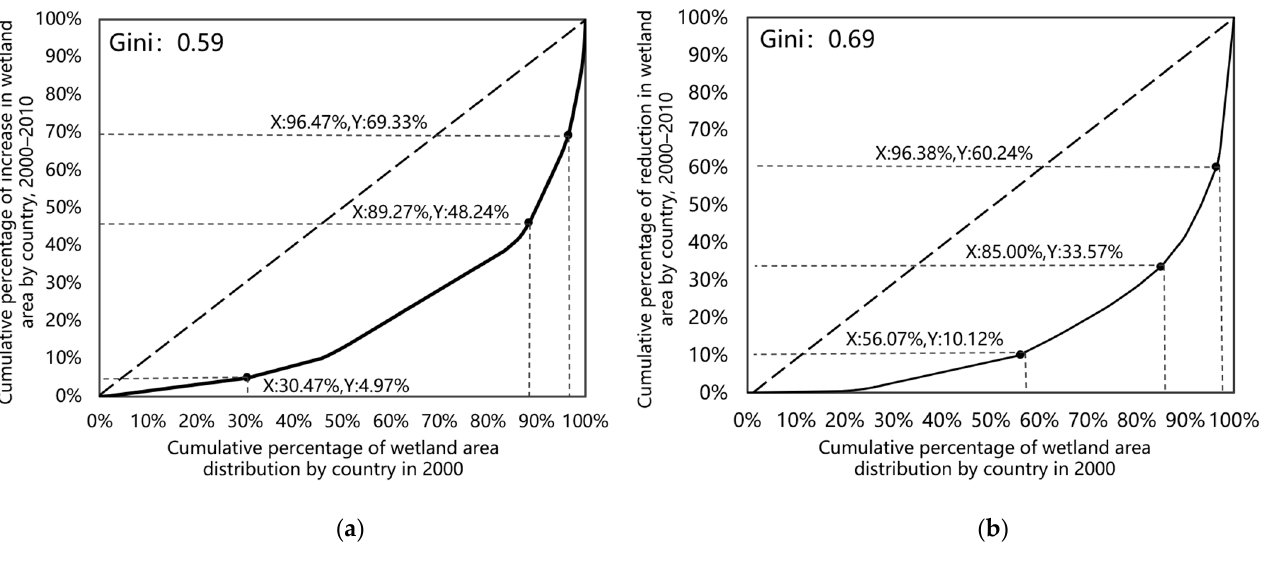
Figure 12. Lorenz curves representing the equality of wetland area changes from 2000 to 2010. ( a ). Lorenz curve for the area increase. ( b ). Lorenz curve for the area decrease.